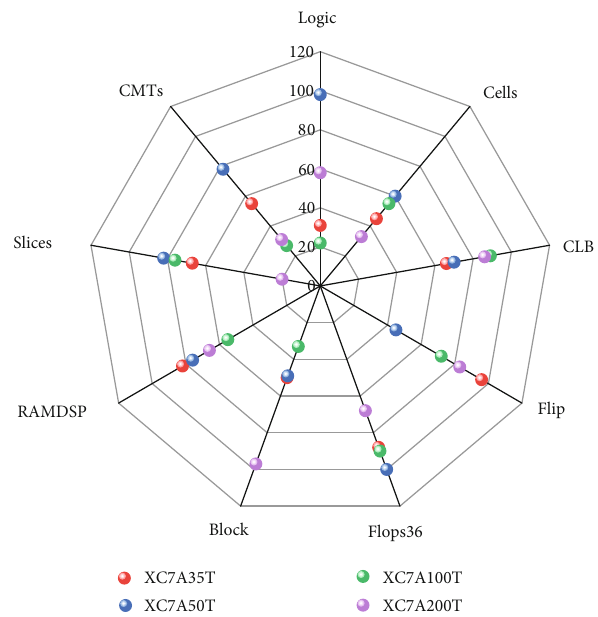
Figure 3: Comparison of internal resources of the chip.